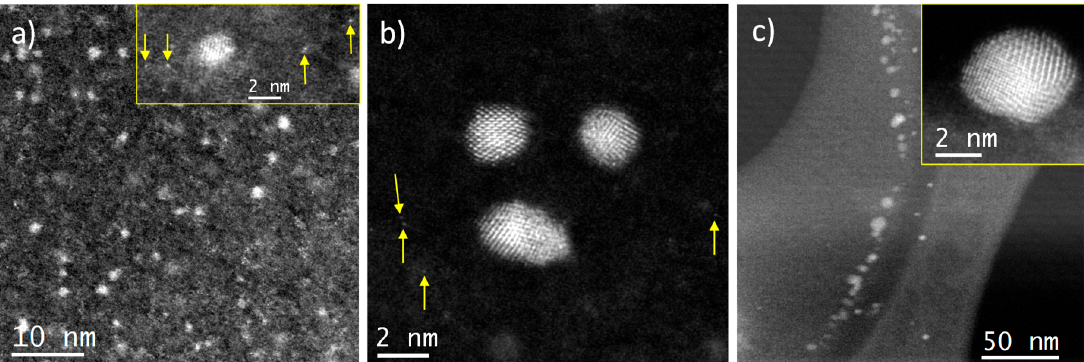
Figure 3. C s -corrected STEM-HAADF of gold entities transferred to the oil phase after one day of contact with the aqua regia solution ( a , b ). The yellow arrows indicate the existence of isolated Au atoms. ( c ) Micrograph corresponding to the sample after 8 days of contact. Inset shows a closer look of a typical nanoparticle.